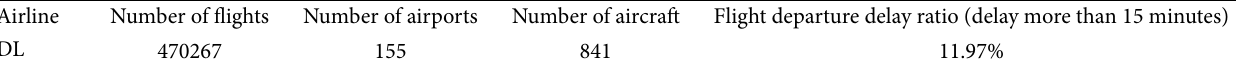
Table 1: The information for DL airline in the second half of 2017.